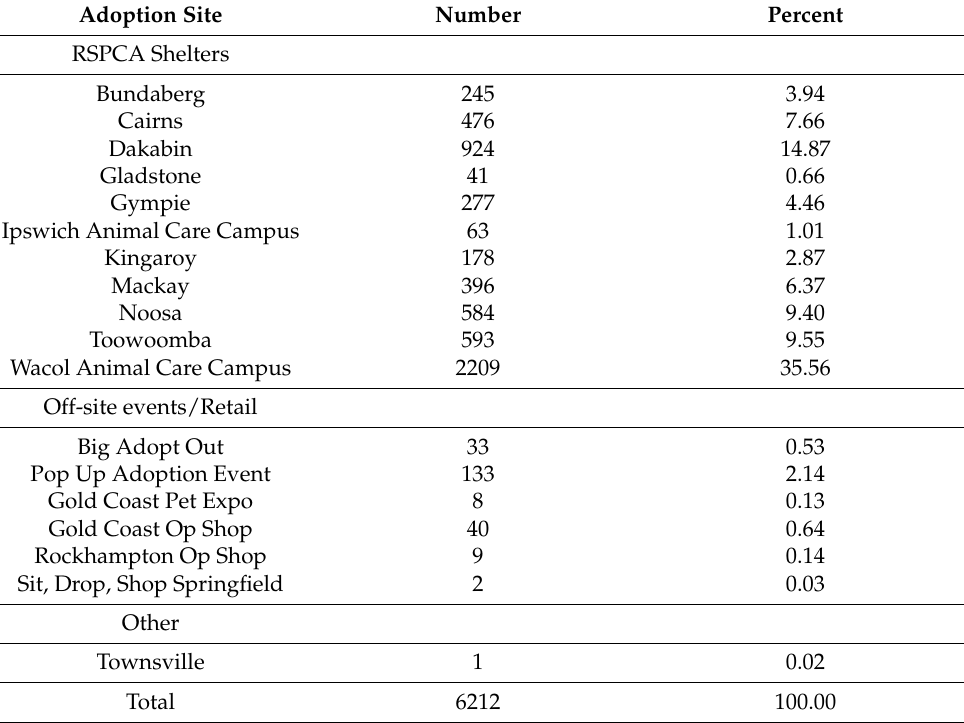
Table A1. Numbers of Dog Adoptions Per Site.